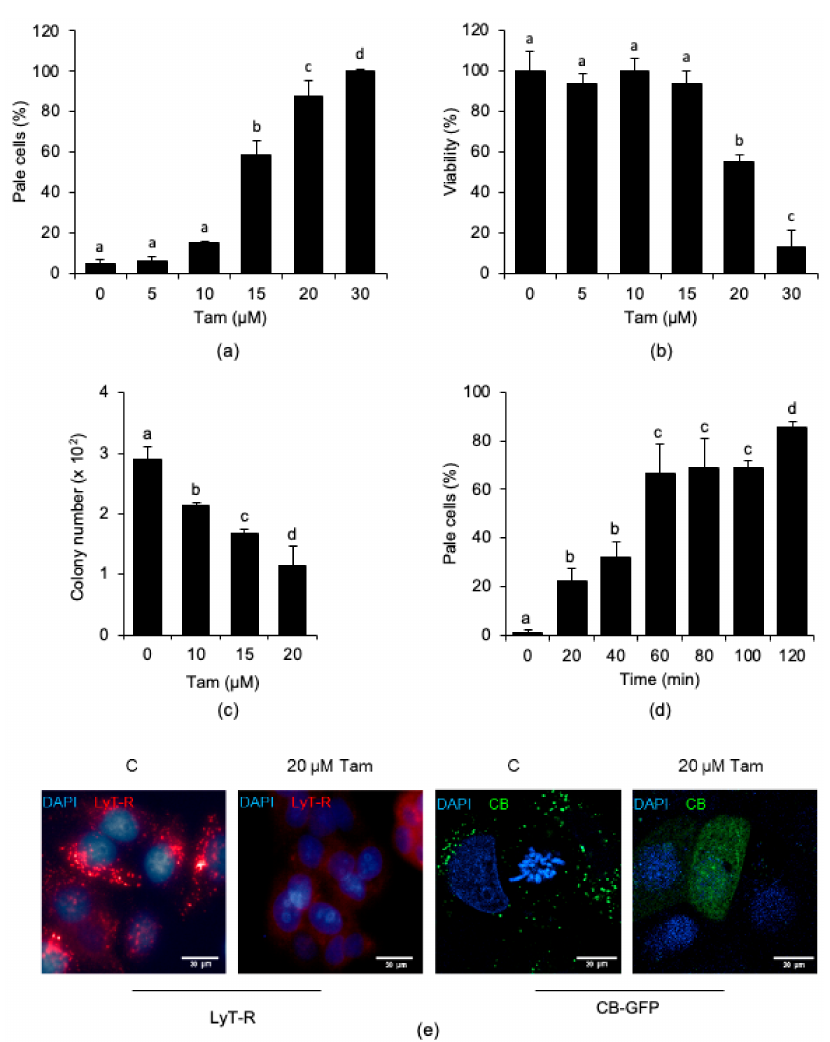
Figure 3. Tam-induced LMP is dose- and time-dependent in MCF7 cells. ( a , b ) Dose-dependency of Tam-induced LMP ( a ) or loss of viability ( b ) in cells treated for 24 h with Tam as indicated. ( c ) Reduction in clonogenic potential of MCF7 cells exposed for 24 h to the indicated concentrations of Tam. ( d ) Time-course of LMP induced by 20 µ M Tam. ( e ) LMP (first and second panels) and release of cathepsin B-GFP (CB-GFP; third and fourth panels) induced by treatment with 20 µ M Tam for 2 h; C and 20 µ M Tam indicate controls and MCF7 cells treated with 20 µ M Tam for 2 h, respectively. For panels ( a – d ), data and statistical analysis are as in Figure 1. Pictures in ( e ) are representative of three independent